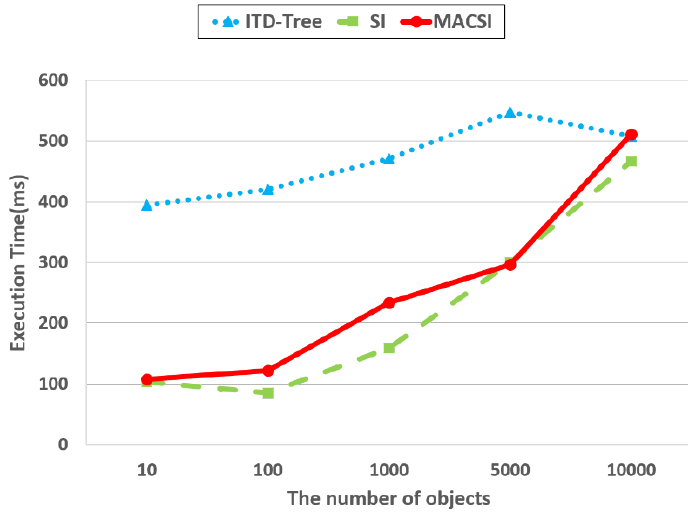
Figure 25. The effect of object number on the coarse-grained semantic object query performance.